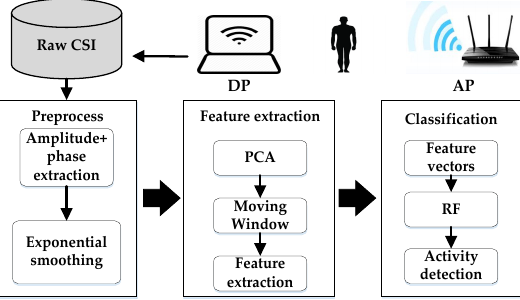
Figure 1. System architecture and work